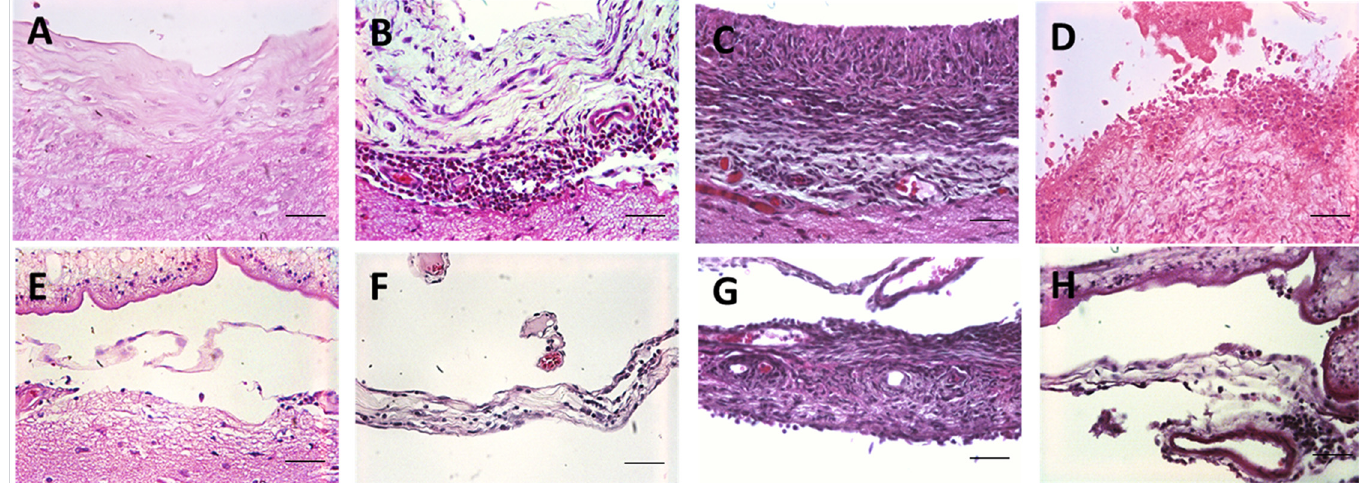
Fig 2. Inflammatory stages in parenchymal and meningeal cysticerci. (A), (B), (C) and (D) are IS1, IS2, IS3 and IS4 in parenchymal tissue, respectively. Collagen and number of cells tend to increase with the degree of inflammation, as previously described by Alvarez [24]. (E), (F) and (G) are examples of IS1, IS2 and IS3 in meningeal tissue, respectively. The collagenous areas in meningeal tissue are usually thinner than in parenchymal tissue and the number of inflammatory cells are decreased compared to the parenchyma tissue. (H) Shows inflamed meningeal vessels — note the inflammatory cells surrounding the vessels (All pictures are from Haematoxylin and eosin stain slides: 400X; bar: 50 μ